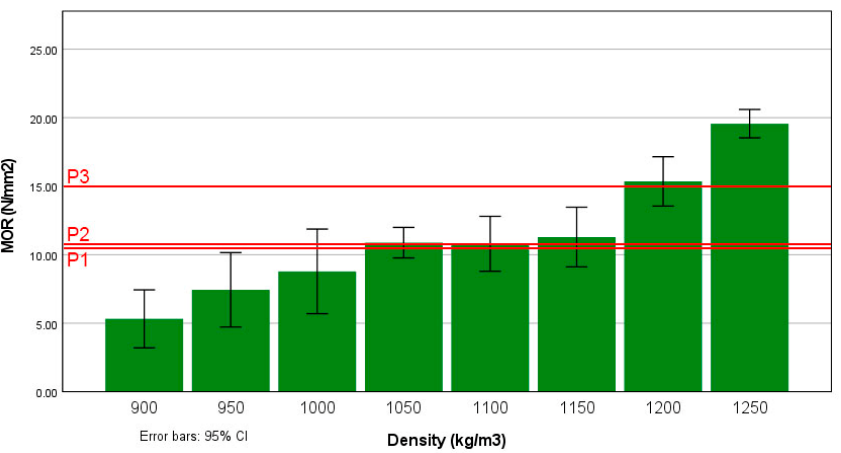
Figure 4. Modulus of rupture (MOR) results of the experimental panels and the minimum require- ments of the European standards [33].